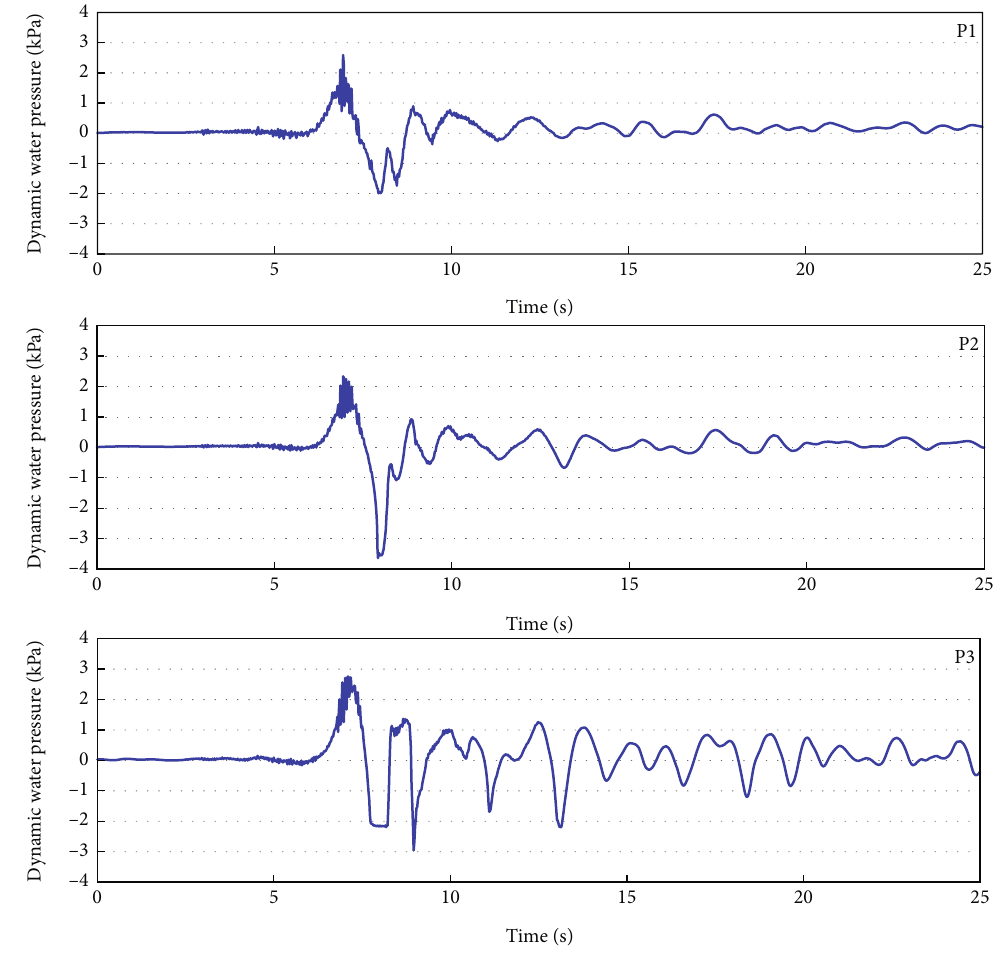
Figure 10: Time history curves of the dynamic water pressure with landslide body T1 at measurement points P1 –